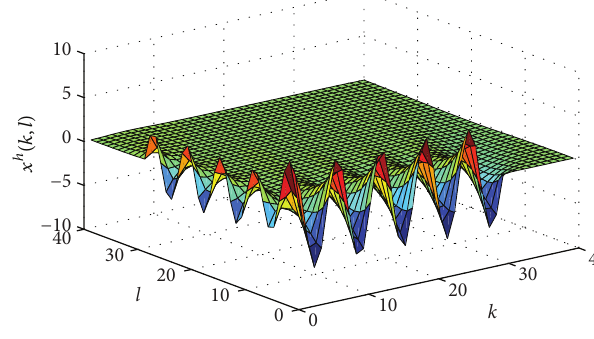
Figure 3: The state trajectory of 𝑥 ℎ (𝑘, 𝑙) with 𝑎 2 = −2.9 .